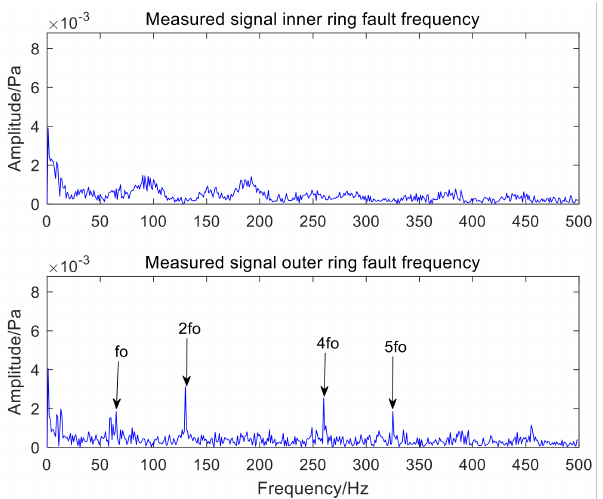
Figure 20. The envelope spectrum of an acoustic signal using the